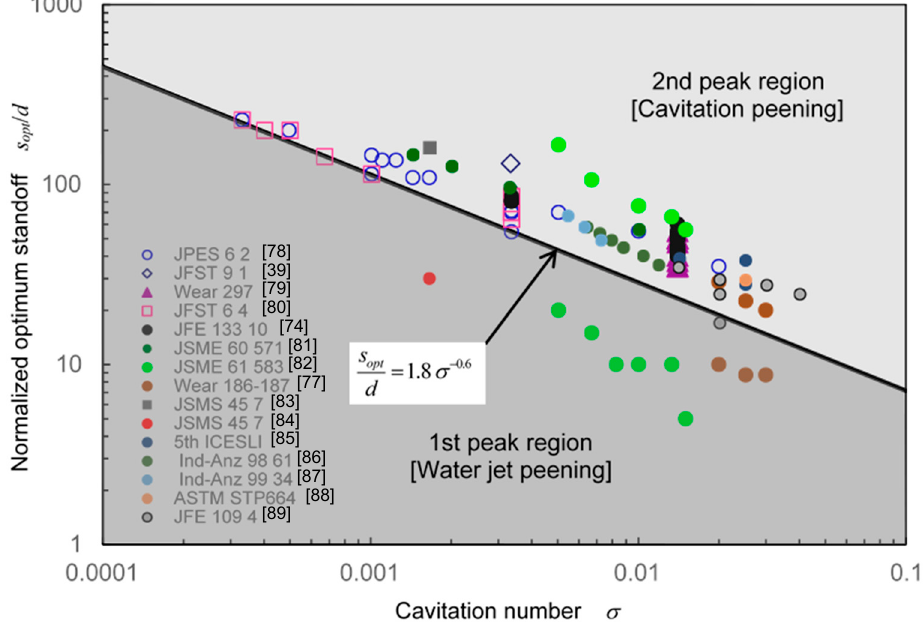
Figure 13. Classification map for cavitation peening and water jet peening considering standoff distance and cavitation number [90].